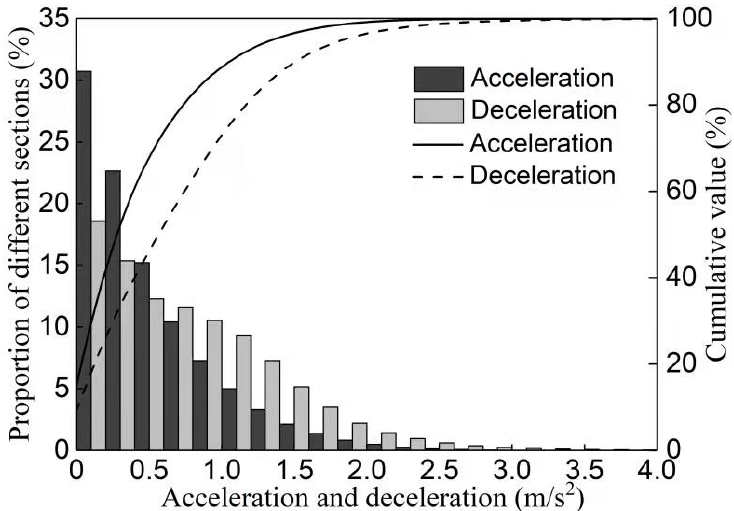
Figure 7. The distribution characteristic of acceleration and deceleration.